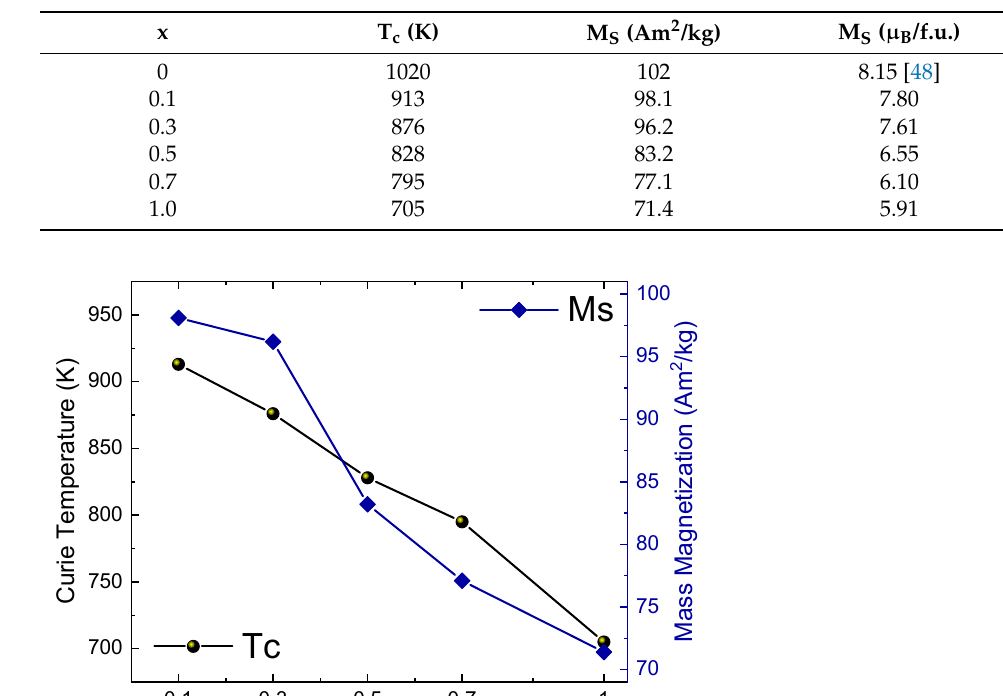
Table 3. Curie temperature and magnetization values of Sm 1 − x (Ce 0.75 La 0.25 ) x Co 5 (x = 0.1–1.0)